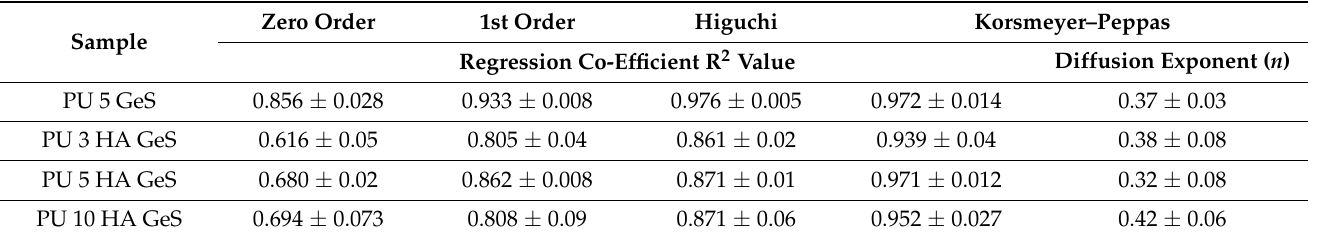
Table 3. The correlation coefficient R 2 from in-vitro-release data of GeS for different release-kinetic models. Zero Order 1st Sample